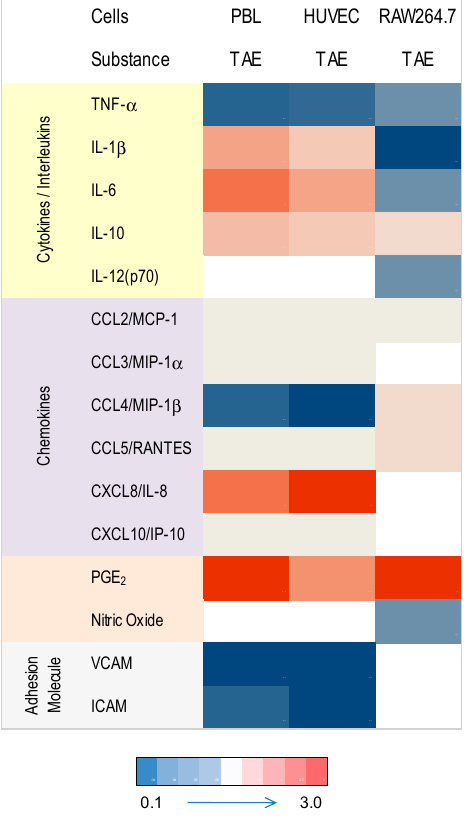
Figure 7. Heat map depicting regulation of inflammatory parameters by TAE across immune and endothelial cells. Values were calculated relative to the metabolite expression or secretion observed in stimulated cells. Intensity of blue and red color grades indicate reduced and increased expression of metabolites, respectively. Empty fields: no data available or values below limit of detection).